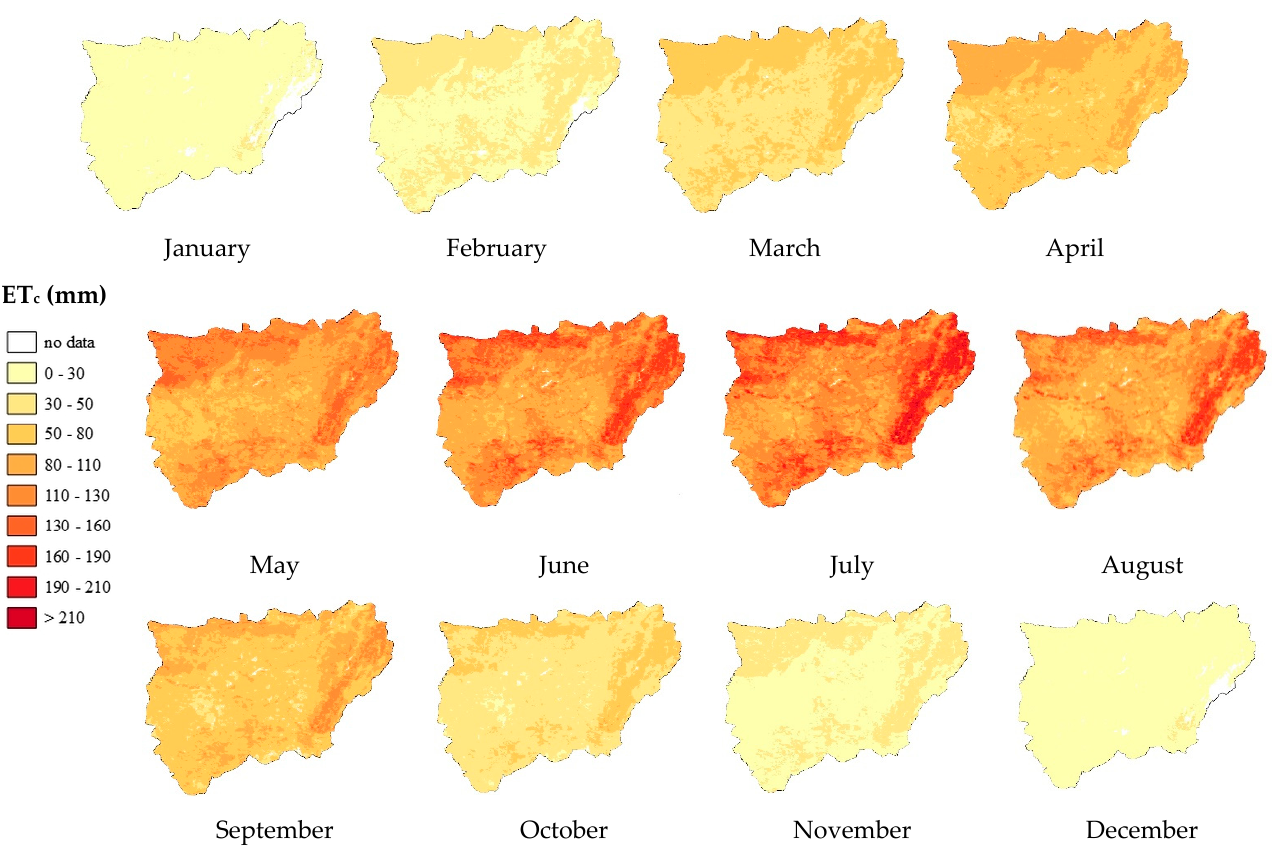
Figure 10. Monthly variation in ET c . (The scale of color is presented on the left of the figure).